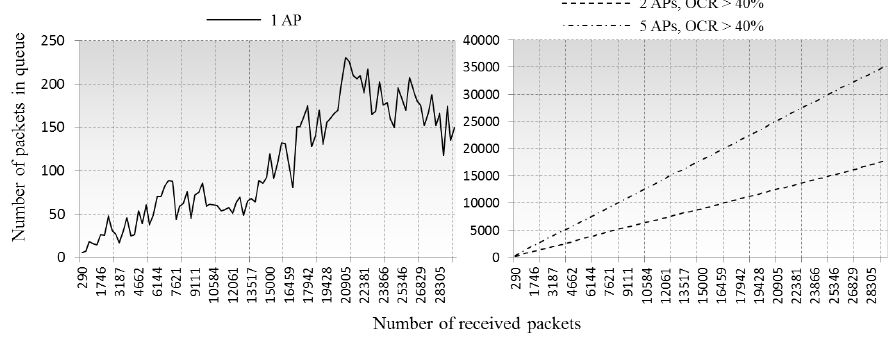
Figure 10. Comparison of number of waiting packets in